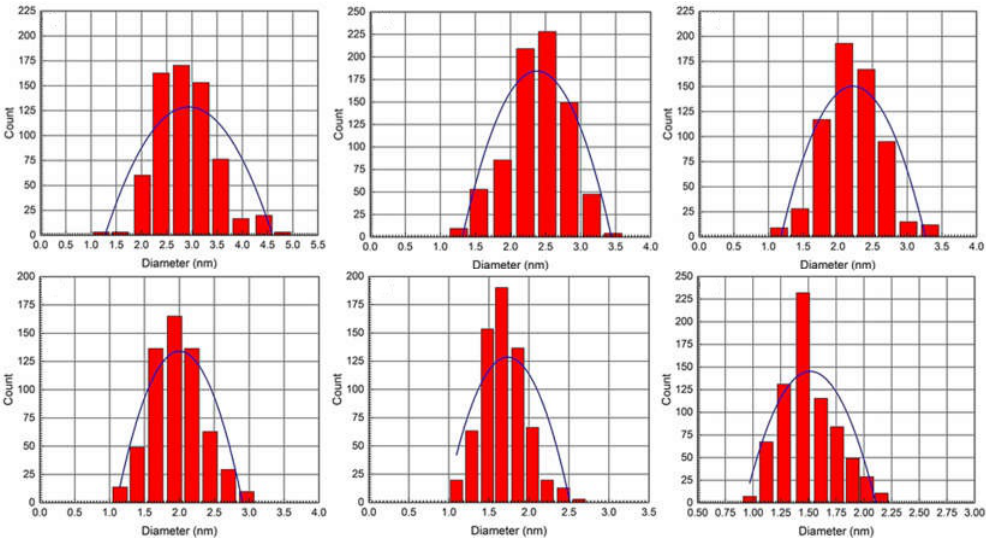
Figure 5. PSD histograms of AgNPs obtained using different BAIILs-based microemulsions.